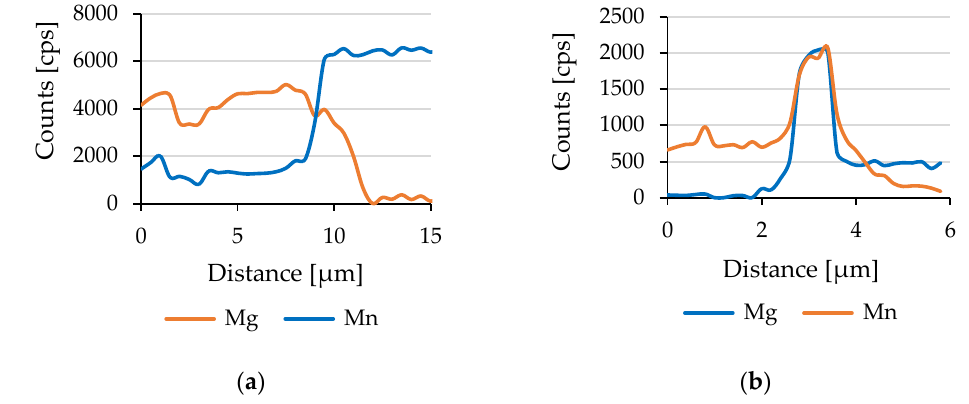
Figure 11. EDS line scans shown in Figure 8b: ( a ) EDS line scan 1 and ( b ) EDS line scan 2.